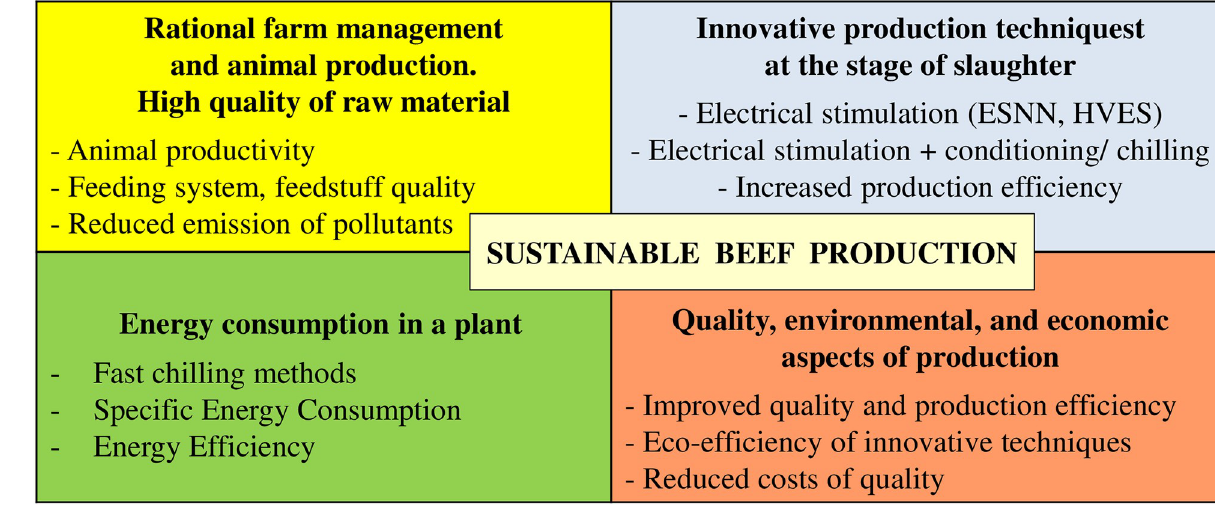
Fig 1. Concept of the sustainable development of beef